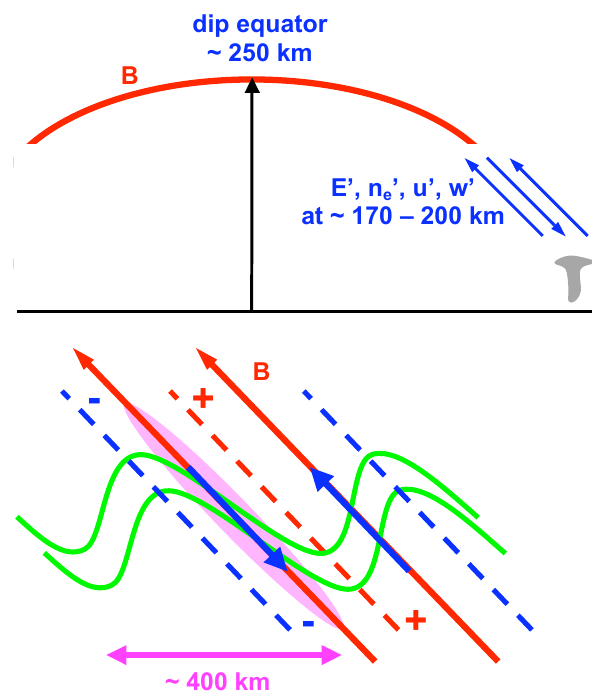
Fig. 7. Schematic cross section along the magnetic field showing GW velocity perturbations and phase orientation (top panel, blue ar- rows) arising from deep convection and aligned along the magnetic field. GW velocity, temperature (bottom panel; dashed lines, red positive, blue negative), and electron density per unit mass (green) and electron density gradient perturbations (pink positive) off the dip equator at altitudes providing an enhanced field line-integrated electron density gradient along the downward phase of the GW. Po- larization electric fields will also arise, but may not contribute to plasma perturbations if they short out to lower